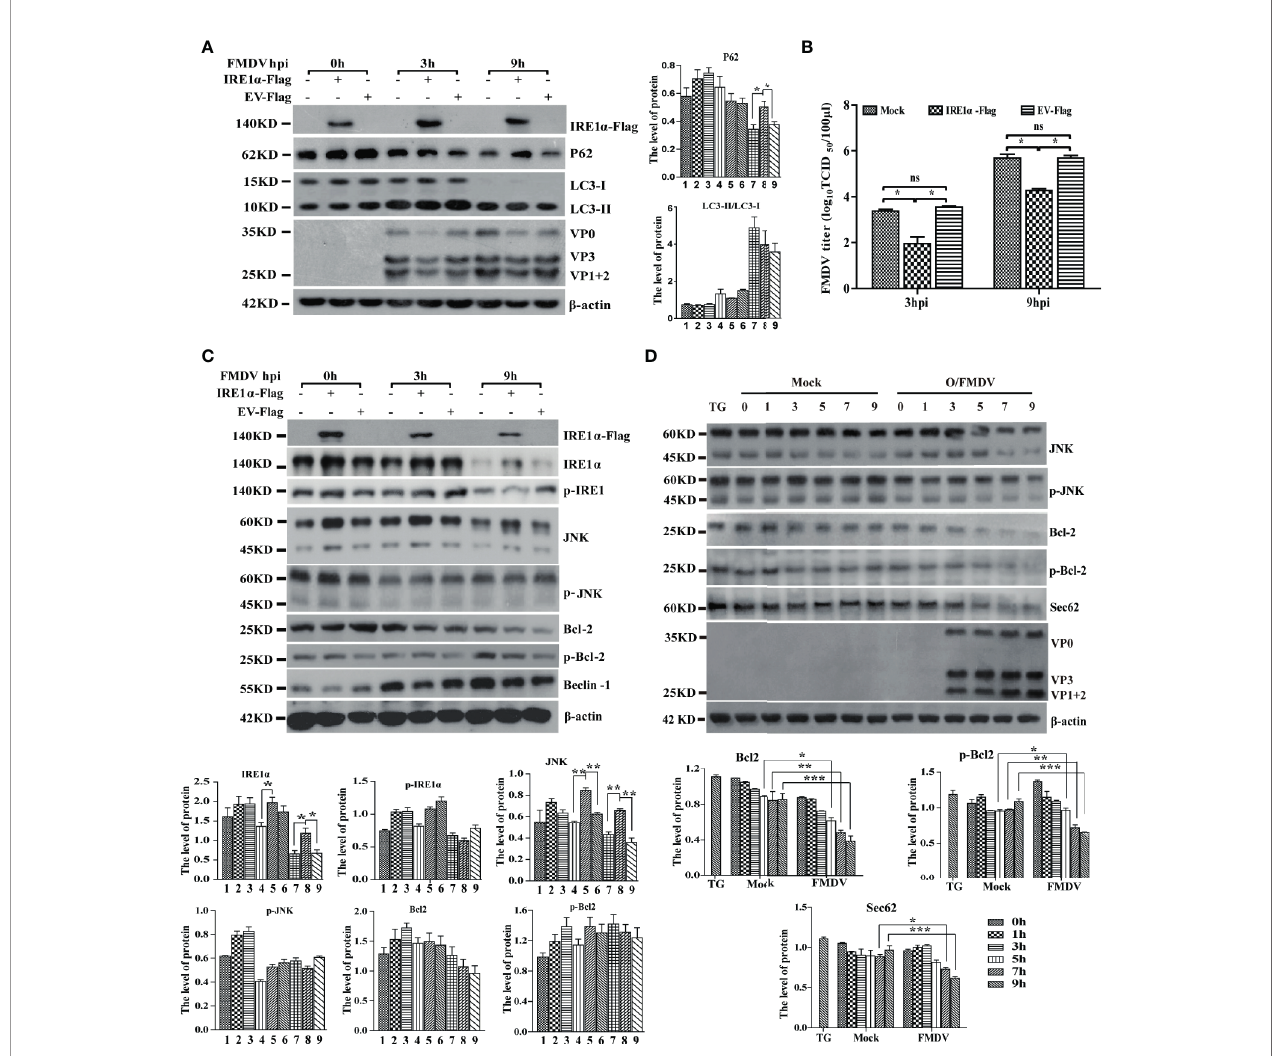
FIGURE 4 | IRE1 a -JNK signaling pathway was involved in FMDV-induced autophagy and viral replication. (A) PK-15 cells were transfected with cognate Flag-IRE1 a and empty vector (EV) for 24 h, followed by FMDV infection. Cell lysates were harvested and subjected to Western blot analysis. The levels of related proteins were normalized to b -actin, data were expressed as means ± SD of three experiments. Every treatment group compared with control groups, respectively; * p < 0.05, ** p < 0.01. (B) The viral titers were determined by TCID 50 in IRE1 a -overexpressed cells. Data are analyzed as mean ± SD; * p < 0.05, ** p < 0.01. (C) The effect of IRE1 a overexpression on IRE1 a -JNK pathway downstream effectors was detected by immunoblotting analysis, containing p-IRE a , JNK, p-JNK, Bcl-2, p-Bcl-2 and beclin-1, and b -actin. The levels of related proteins were normalized to b -actin; data were expressed as means ± SD of three experiments. Every treatment group compared with control groups, respectively; * p < 0.05, ** p < 0.01. (D) The levels of IRE1 a -JNK pathway-related proteins and Sec62 were detected by Western blot in FMDV-infected PK-15 cells. The levels of related proteins were normalized to b -actin; data were expressed as means ± SD of three experiments. Every treatment group compared with control groups, respectively; * p < 0.05, ** p < 0.01, *** p < 0.001. ns, no signi fi